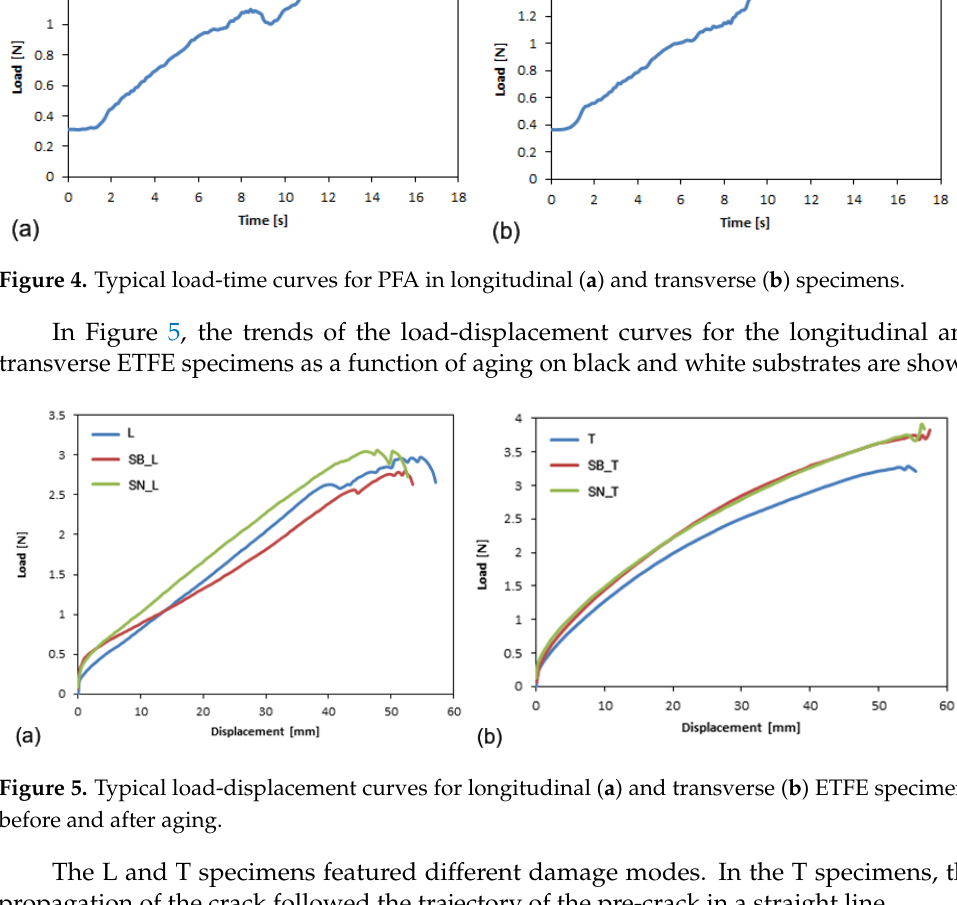
Figure 4. Typical load-time curves for PFA in longitudinal ( a ) and transverse ( b ) specimens.